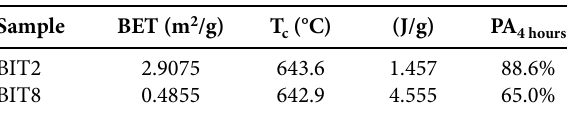
Table 2: Results for BET, DSC and PA measurements of BIT2 and BIT8